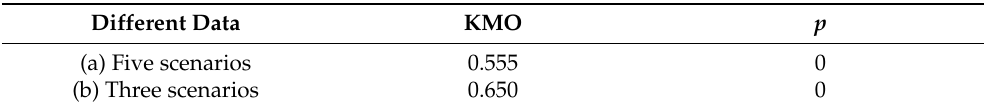
Table 2. KMO and Bartlett